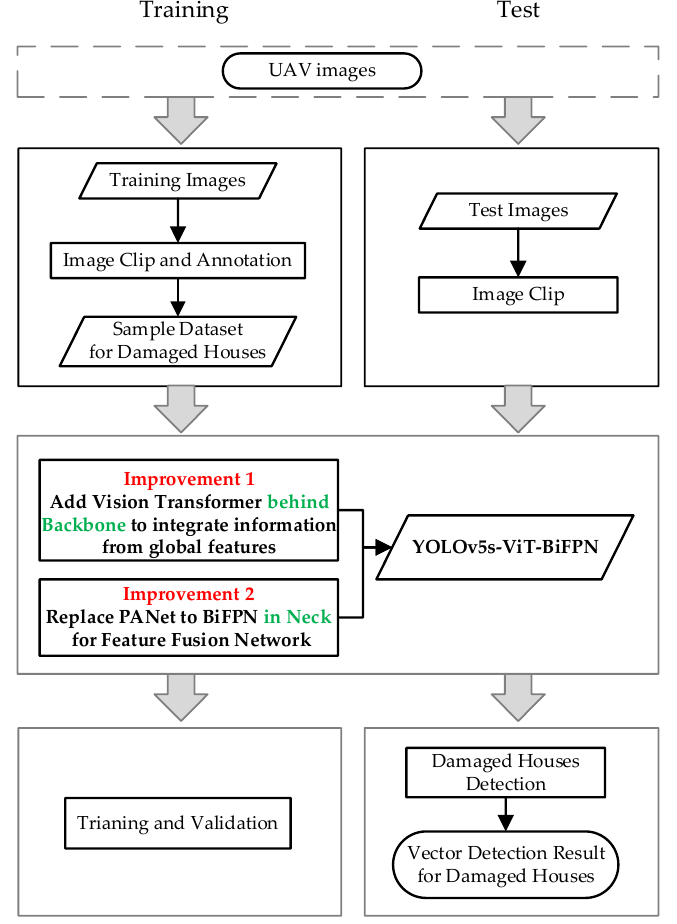
Figure 1. The flow for the automatic extraction of damaged houses based on